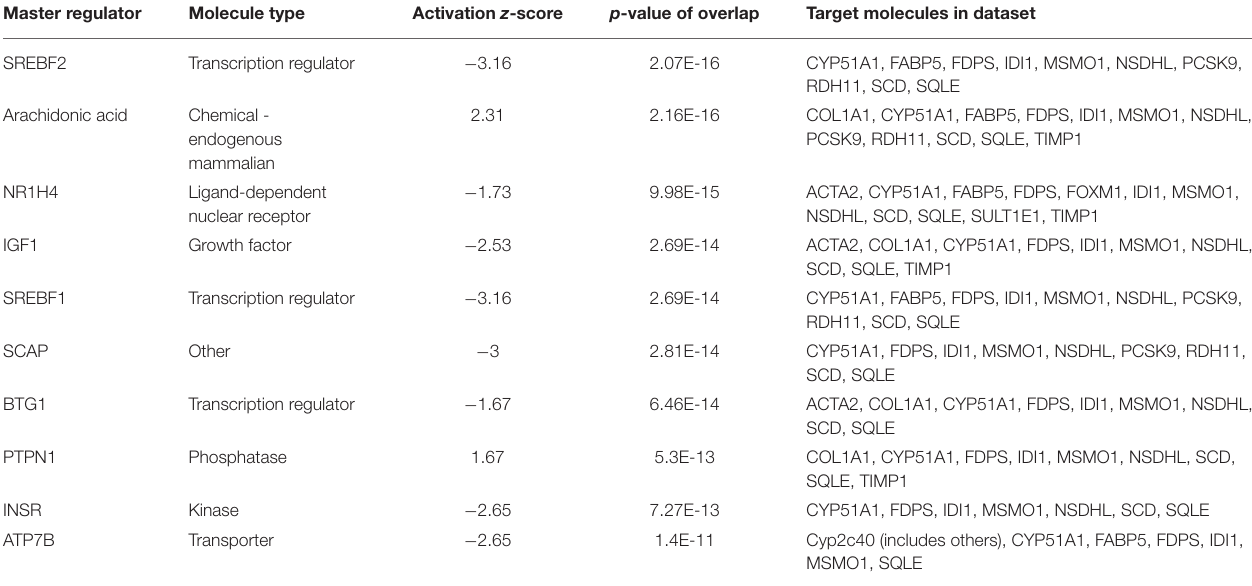
TABLE 5 | Causal network regulators between Phb1 + / − and WT. Master